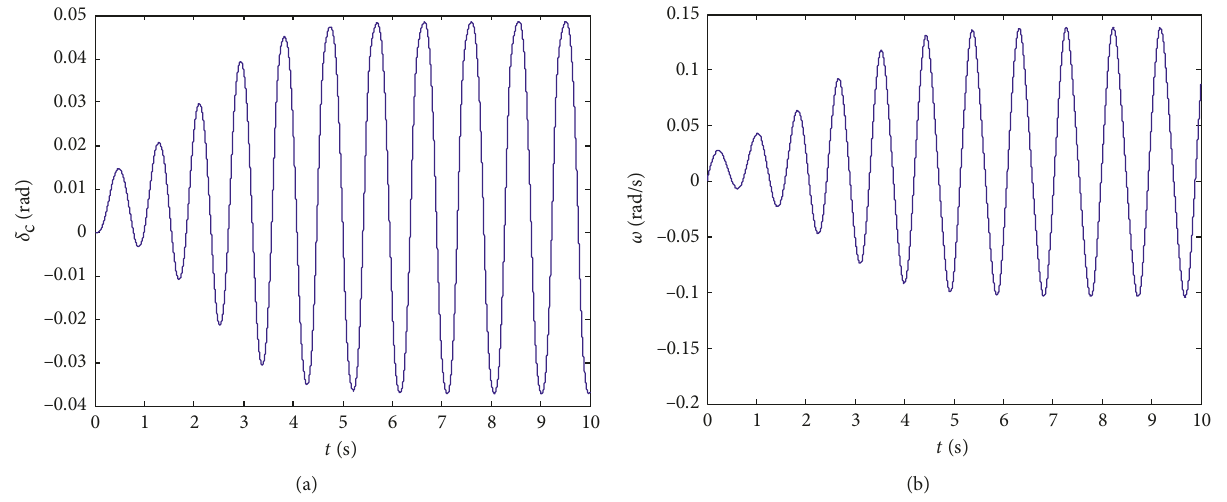
Figure 5: Time history of (a) compliance steering angle and (b) yaw rate, for the case of u